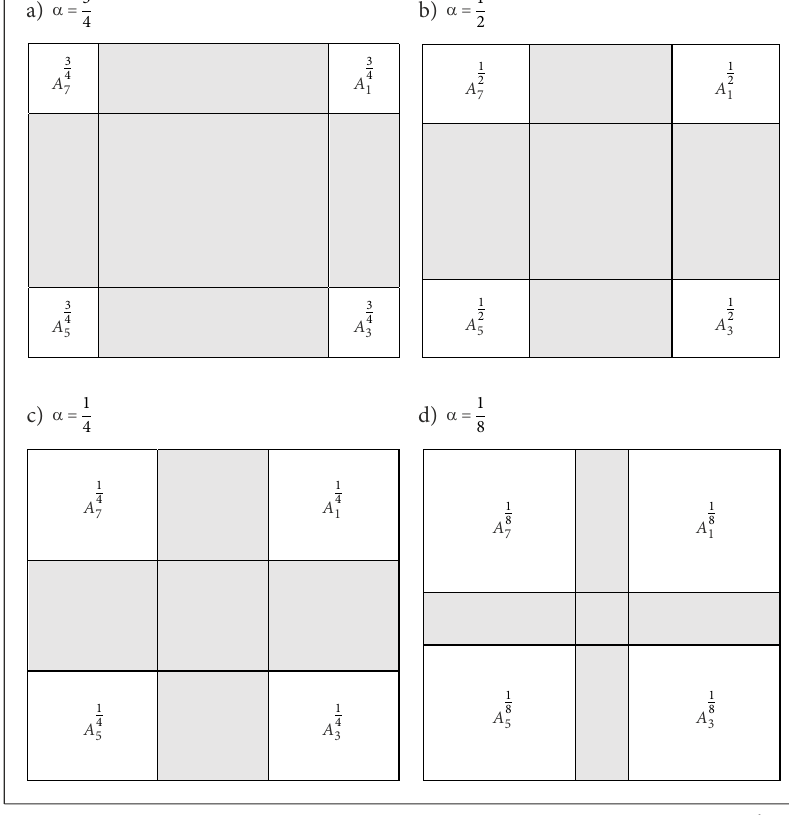
Figure 7. Unambiguous sets of attributes for different confidence values (from a to